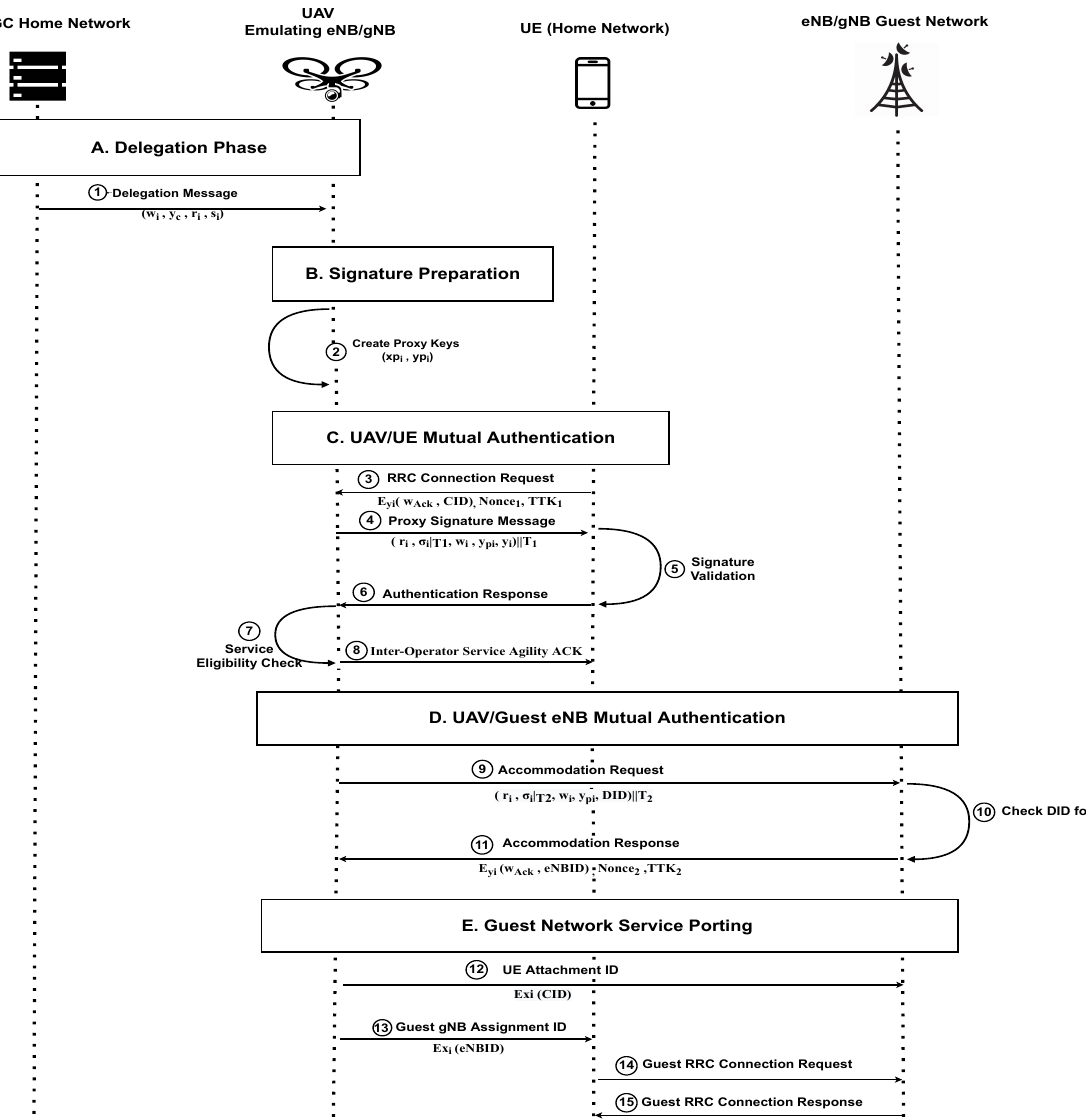
Figure 3. The proposed authentication mechanism exchange